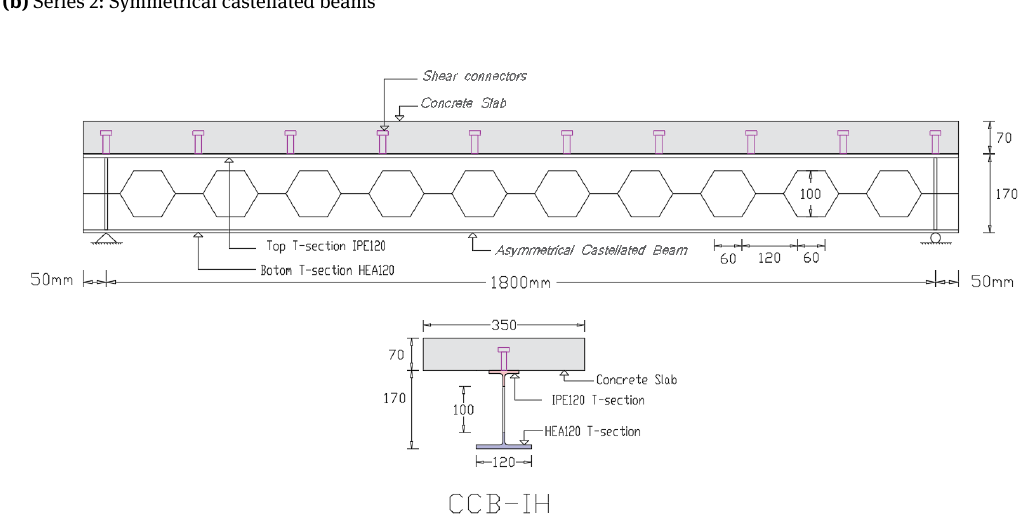
Figure 5: Dimensions and details of composite steel-concrete